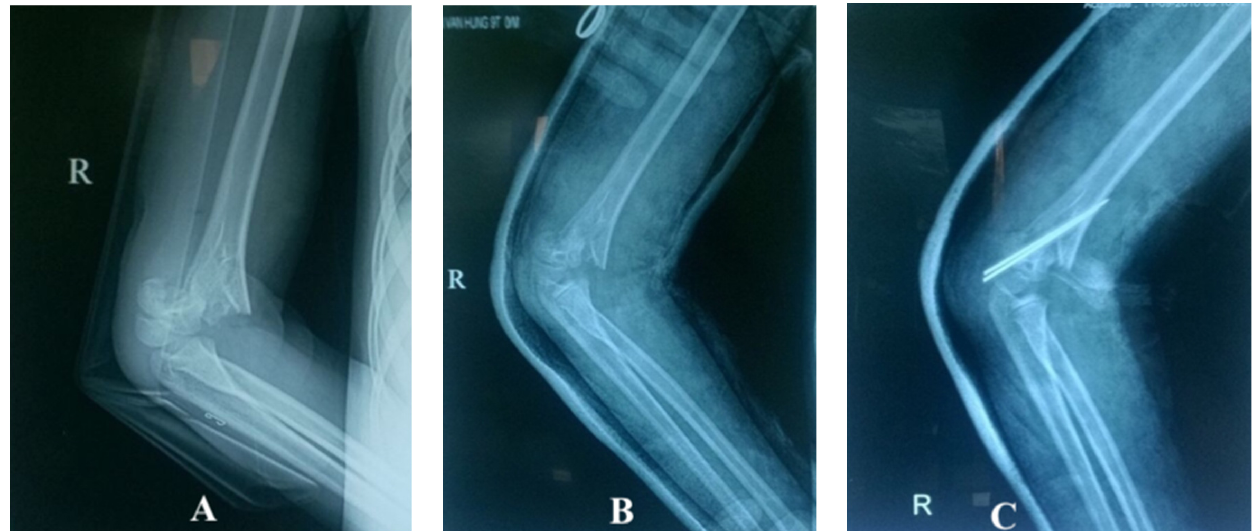
Figure 4. X-rays of supracondylar fractures of the humerus. ( A ) Before reposition—Gartland type III. ( B ) After reposition— Gartland type II. ( C ) After operative pinning—Gartland type II.